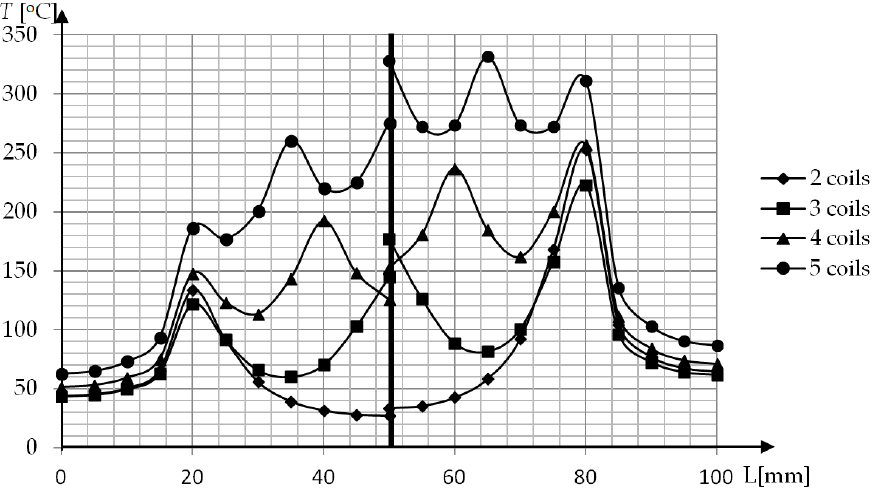
Figure 11. Cavity surface temperature distribution after induction heating (t = 10 s) for a different number of coils. P2—left, P3—right.